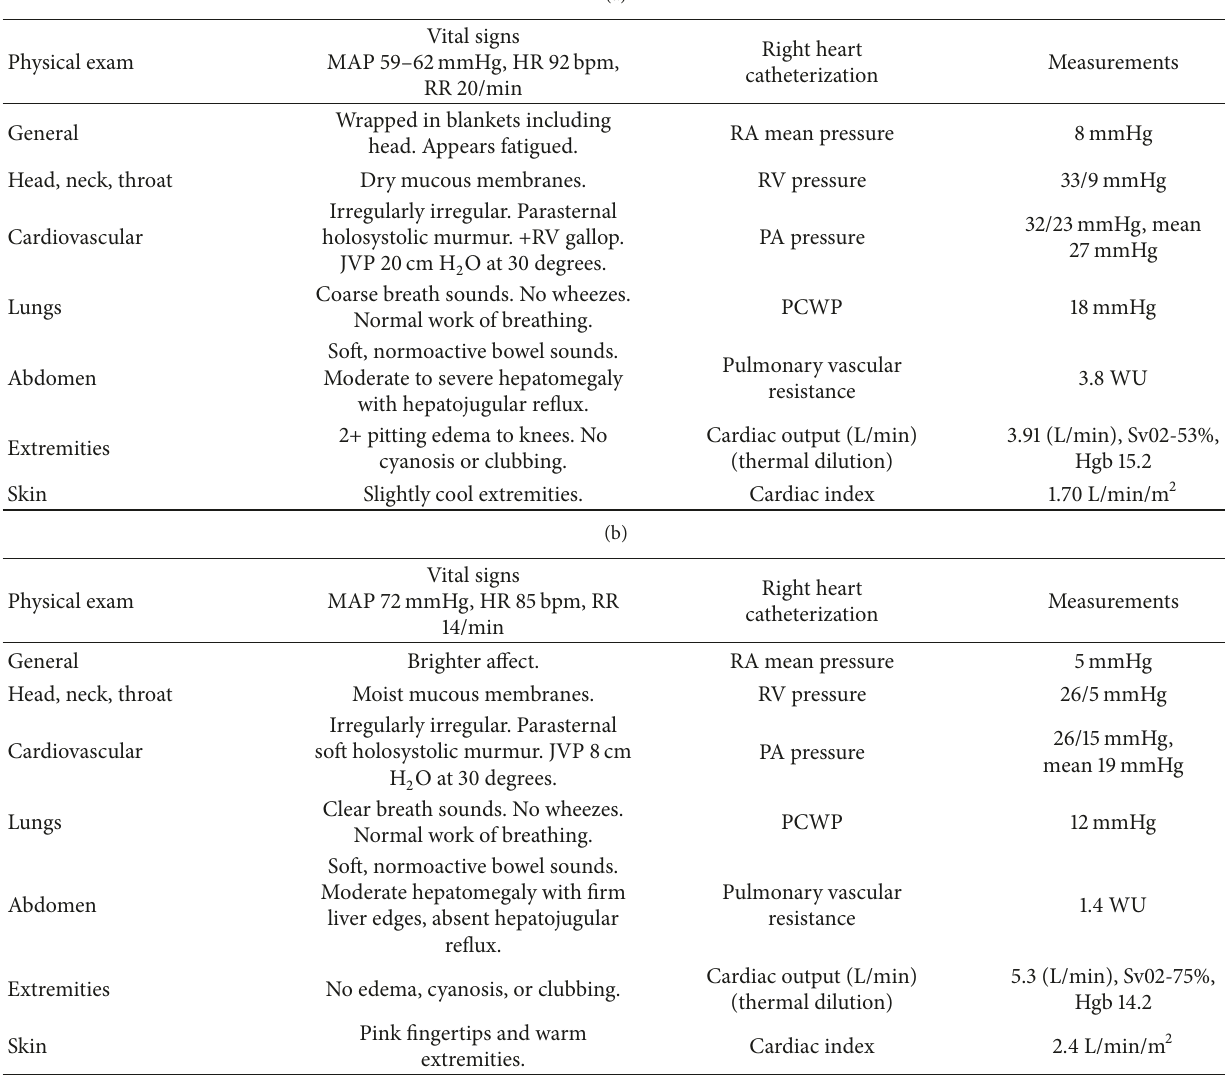
Table 3: (a) The clinical exam and hemodynamic profile consistent with low output heart failure prior to treatment with dobutamine infusion. (b) The clinical exam and hemodynamic profile after treatment with dobutamine